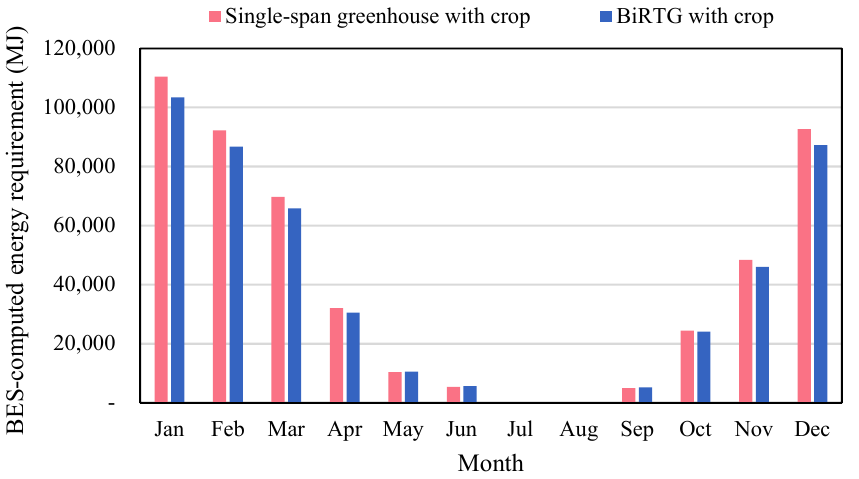
Figure 12. Comparison of monthly energy loads of a single-span greenhouse and BiRTG with crop.